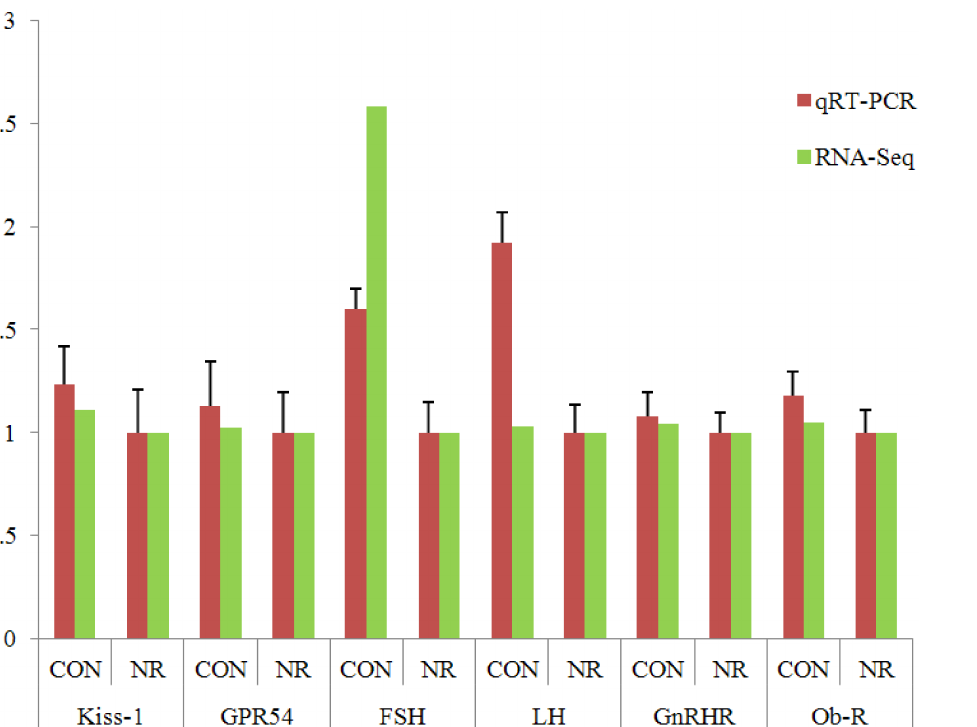
Fig 3. Validation of RNA-Seq data by qRT-PCR. Results are expressed as the target/reference ratio of each sample normalized by the target/reference ratio of the calibrator. β -actin was used as a reference gene. The vertical axis indicates the fold change of transcript abundance in CON gilts compared to the NR. For the NR sample, the fold change of transcript abundance relative to the NR sample equals one, by definition. qRT-PCR: the RNA samples from independent RNA extractions from six biological replicates; RNA-Seq: the results of deep RNA sequencing. Error bars represent standard error. CON denotes normally fed gilts (2.86 kg/d) and NR denotes nutrient restricted gilts (1 kg/d). GPR54: G protein-coupled receptor 54, FSH: follicle stimulating hormone, LH: luteinizing hormone, GnRHR: gonadotropin-releasing hormone receptor, Ob-R: leptin receptor.